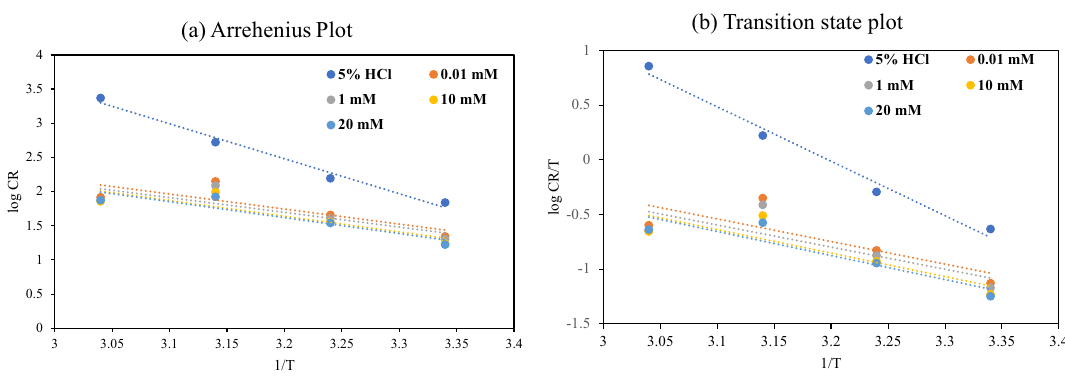
Figure 4. ( a ) Arrhenius plot, ( b ) transition state